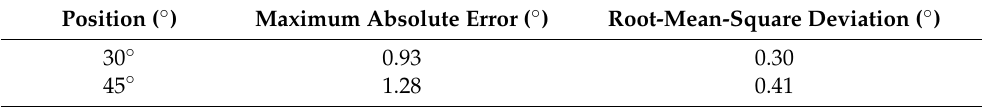
Table 4. Error in path-tracking positioning control for the shoulder joint.